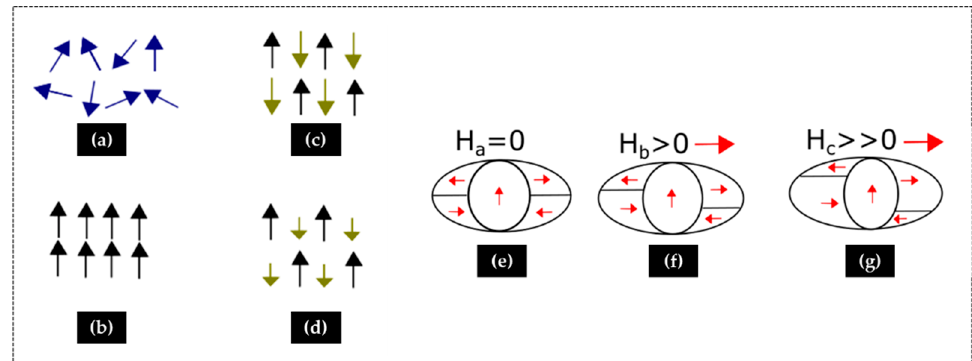
Figure 4. Magnetic interactions: ( a ) paramagnetic, ( b ) ferromagnetic, ( c ) antiferromagnetic, and ( d ) ferrimagnetic. Scheme of domains growing in a ferromagnet at: ( e ) zero magnetic field; ( f ) weak magnetic field; ( g ) strong magnetic field.